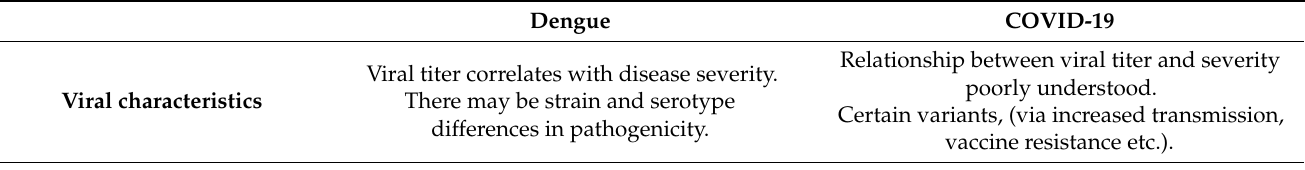
Table 2. Risk factors for severe dengue and COVID-19, based on Centers for Disease Control and Prevention guidance [27–29]. Dengue COVID-19 Relationship between viral titer and severity Viral titer correlates with disease severity. poorly understood. Viral characteristics There may be strain and serotype Certain variants, (via increased transmission, differences in pathogenicity. vaccine resistance